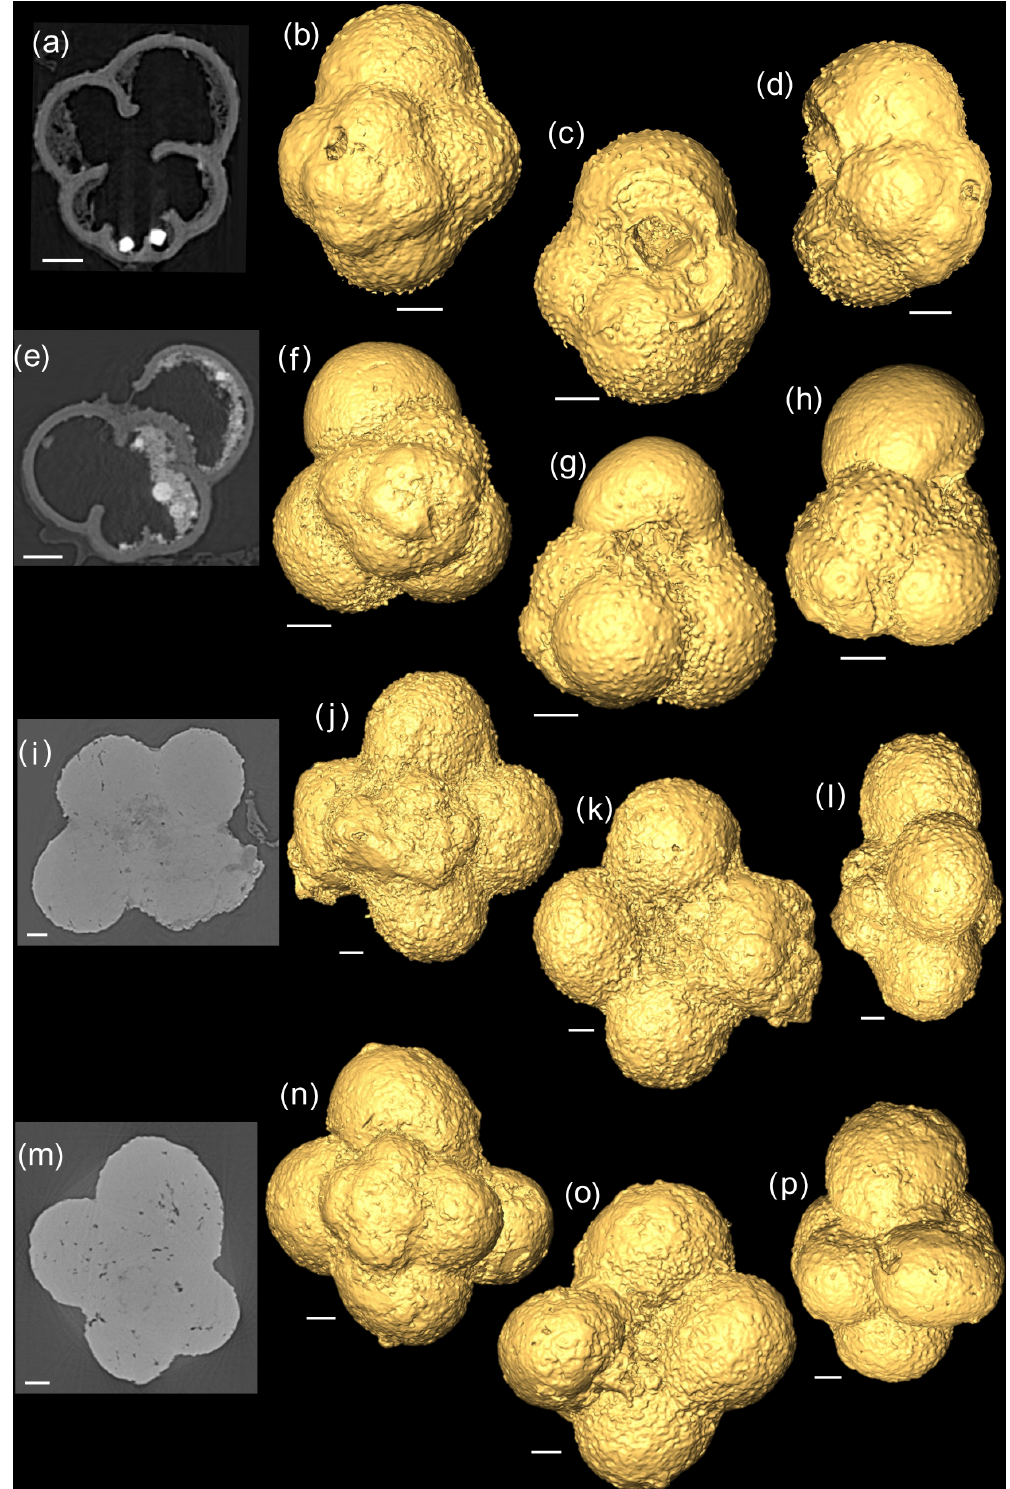
Figure 2. 2-D scans and 3-D isosurface reconstructions of Jurassic specimens from Avizo 8.0 (spiral, umbilical, side view). (a–d) Globu- ligerina bathoniana ; (e–h) Globuligerina oxfordiana ; (i–l) Globuligerina balakhmatovae ; (m–p) Globuligerina tojeiraensis . All scale bars